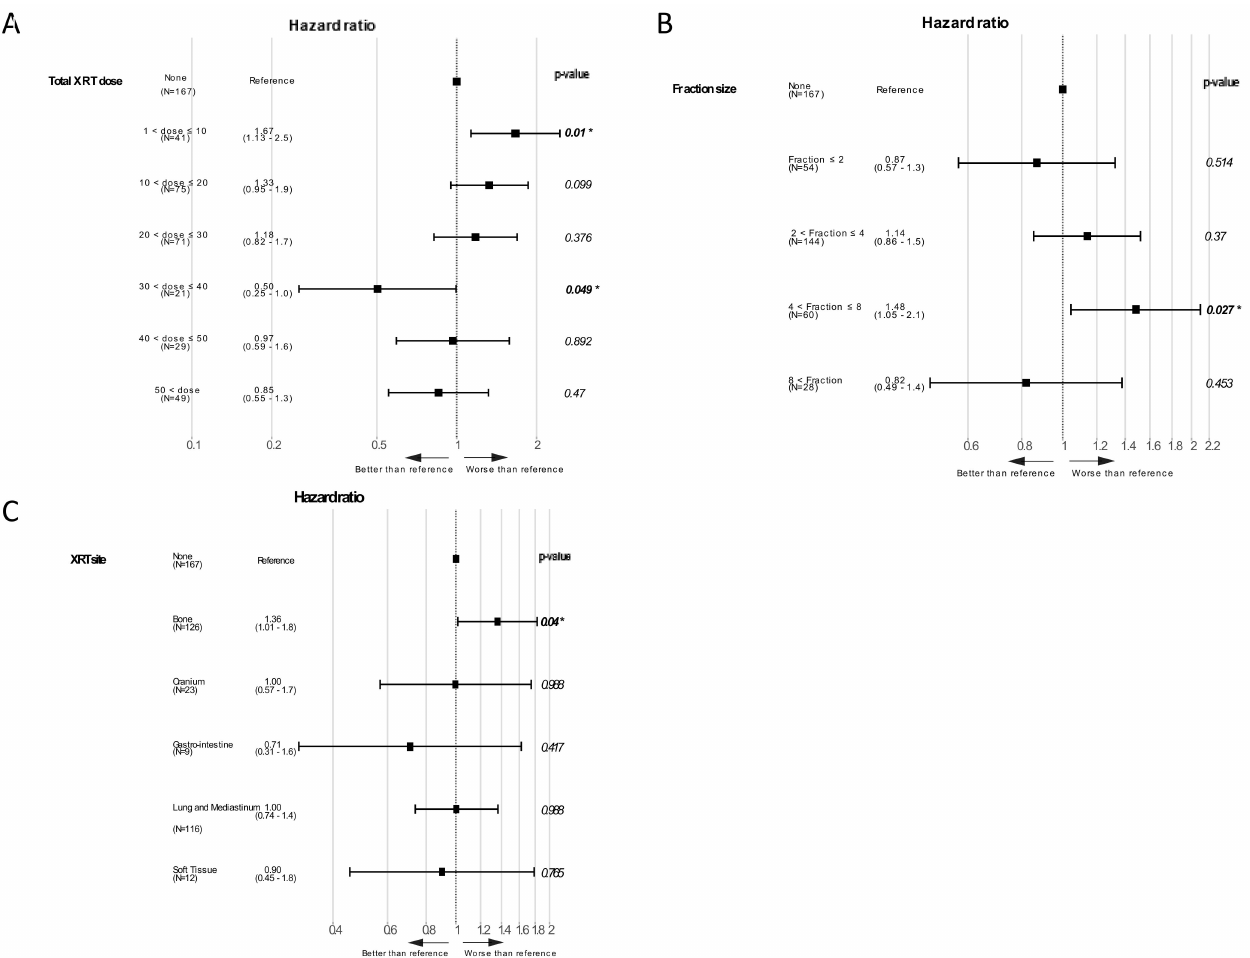
Figure 3. Forest plot demonstrating the overall survival hazard ratio and 95% CI of patients, ( A ) grouped by the total dose received, ( B ) grouped by fraction size and ( C ) grouped by the site irradiated. In all cases, each sub-group is compared to the non-irradiated group, the hazard ratio with 95% CI are depicted and the p -value presented. p -values smaller than 0.05 are in